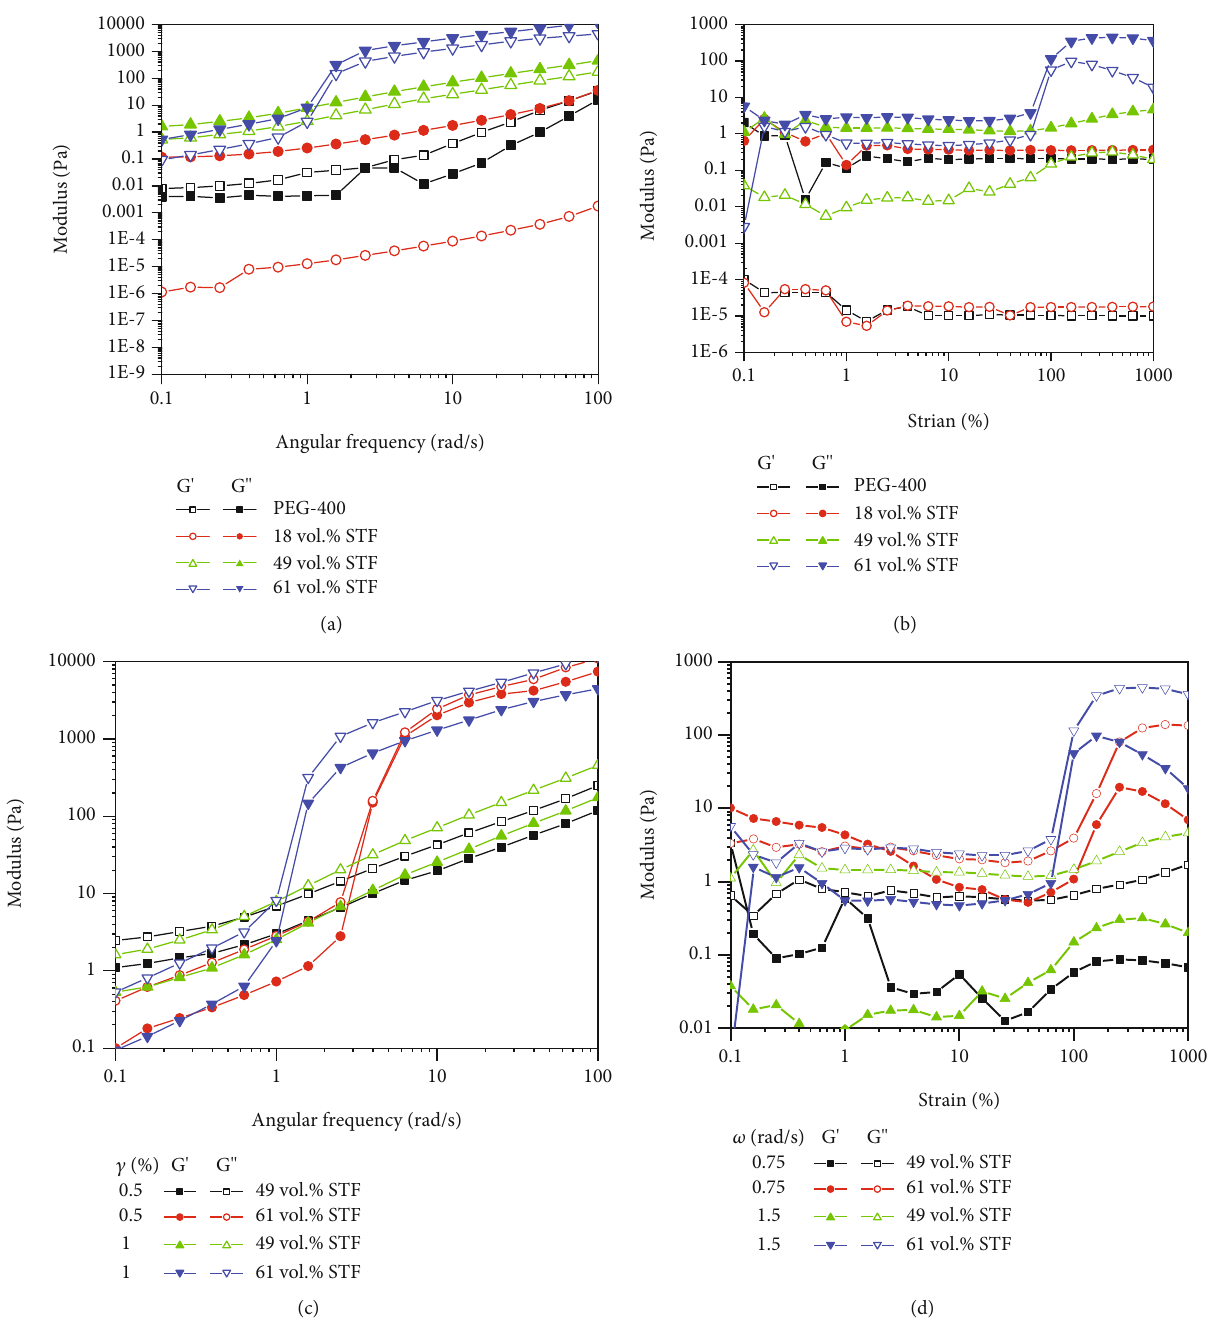
Figure 5: (a) Frequency sweep at the strain of 100% and (b) LAOS test with the angular frequency at 1.5rad/s for PEG-400 and STF. (c) Frequency sweep in the strain range from 0.5 and 1 and (d) LAOS test in the angular frequency range from 0.75 to 1.5rad/s of 49 vol.% STF and 61vol.%